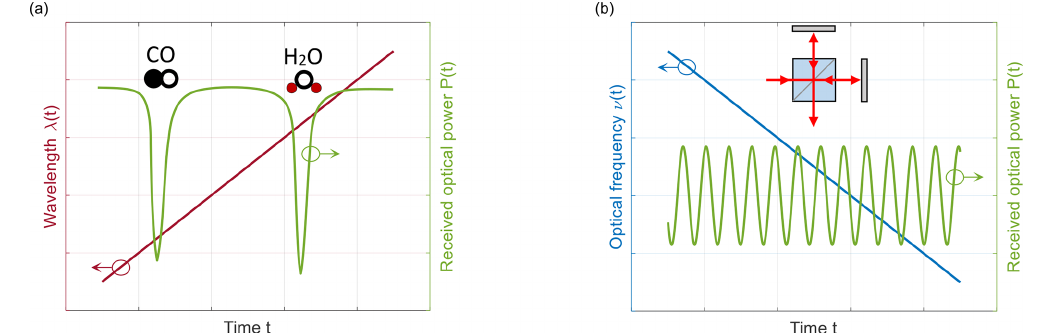
Figure 1. Sketch of wavelength (red) and optical frequency (blue) tunable sources for applications in (a) spectroscopy and (b) for optical frequency domain reflectometry. The green lines show symbolic measurement results of the optical power during the sweep (a) for gas absorption and (b) for the output of an interferometer.